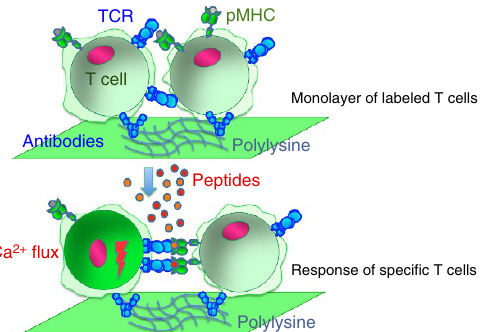
Figure 1 | Schematic presentation of CaFlux assay. T cells form monolayers on the glass bottom of the well covered with antibodies against T-cell’s surface receptors. A peptide antigen is injected into the well. The peptide molecules bind to MHC proteins expressed on the T-cell surface to form recognizable pMHC ligands. Each Tcells can serve as a target cells for neighbouring T cells, but only rare antigen-specific T cell is expected to recognize and respond to defined antigenic peptide used in the assay. Recognition events induce rise in the level of intracellular Ca 2 þ . To detect Ca 2 þ influx, the T cells are labelled with Ca 2 þ sensitive fluorophore. The changes in fluorescent intensity in individual cells before and after peptide addition are measured with fluorescent microscopy to identify the frequency of responding T